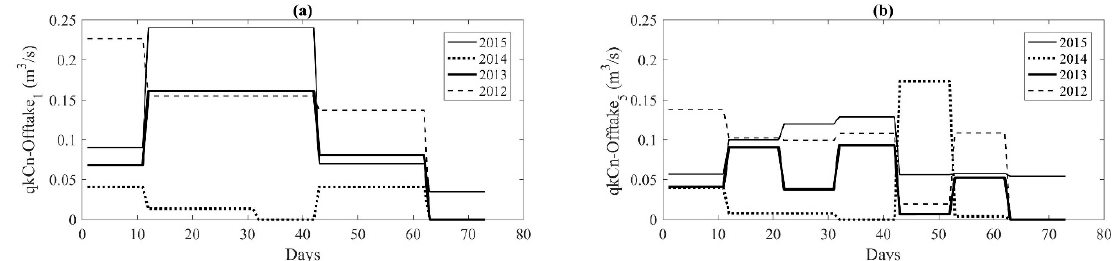
Figure 7. For every year, the variability of the diverted discharges for the reference offtake (Offatake 1 ) ( a ) and for a generic offtake (Offtake 5 ) ( b ).